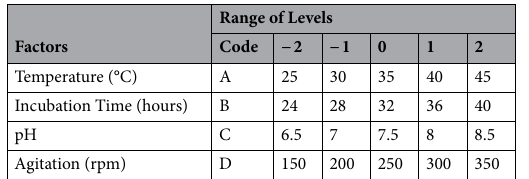
Table 7. Actual and coded values of the factors in employment in the